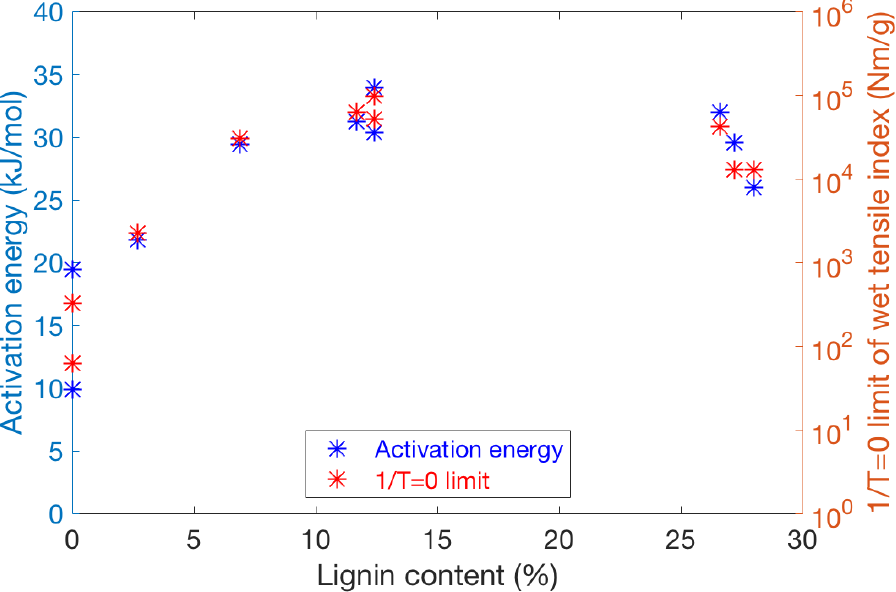
Figure 7. The apparent activation energy (left vertical axis) and extrapolated ln(Wet tensile strength index) at 1/T = 0 (right logarithmic axis) for different pulps with varied lignin content. The extrapolation omits the degradation of fibre-wall polymers and therefore does not describe the true high-temperature limit of wet tensile index. The points up to 12% lignin content describe kraft pulps with varied cooking times in pulping. These results are compared with similar data for CTMP and TMP with lignin content of 26–28%.